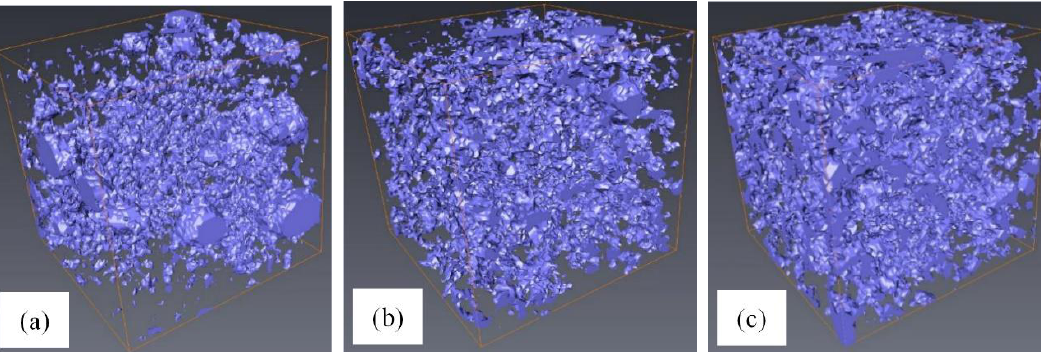
Figure 10. Pore structure of cement stone at 28 days under different w/c ratios using micro-CT ( a ) 0.40; ( b ) 0.44; ( c ) 0.50.